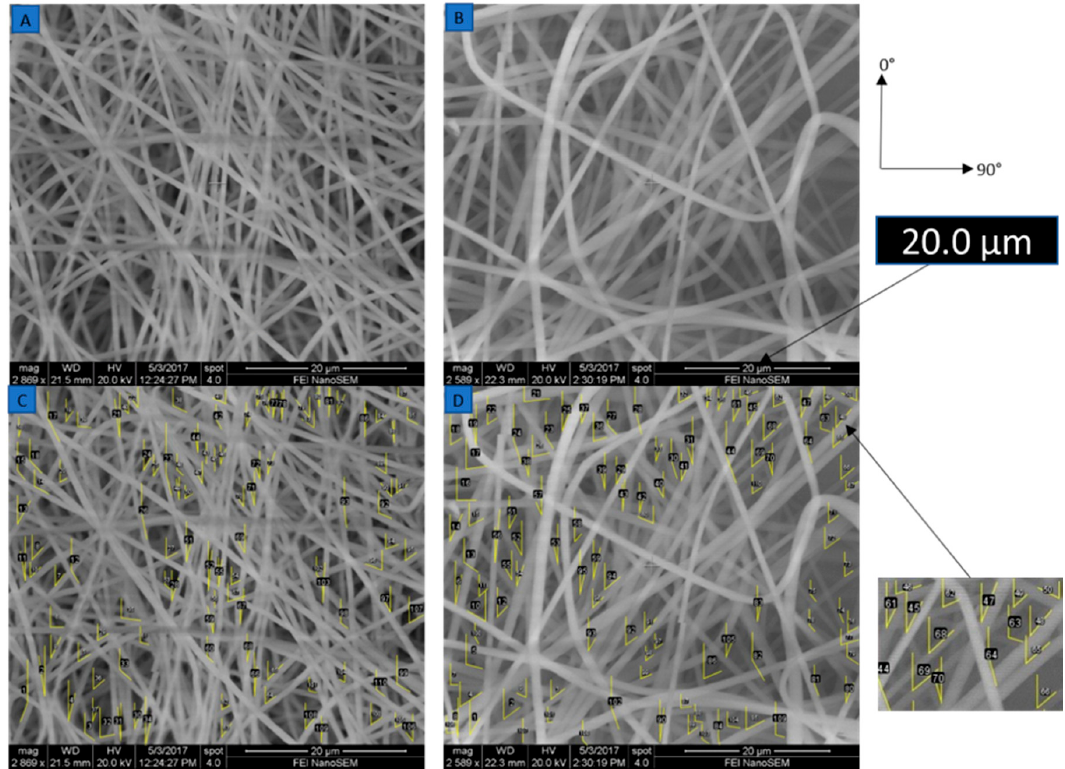
Figure 16. SEM images and angular measurements of mats from the ( A ) 4 V–8 wt.% mat, and ( B ) 5V–8 wt.% mat. Orientations are measured using Image J software for ( C ) 4 V–8 wt.% mat and ( D ) 5 V–8 wt.% mat. Additional data is available in the supplementary file.